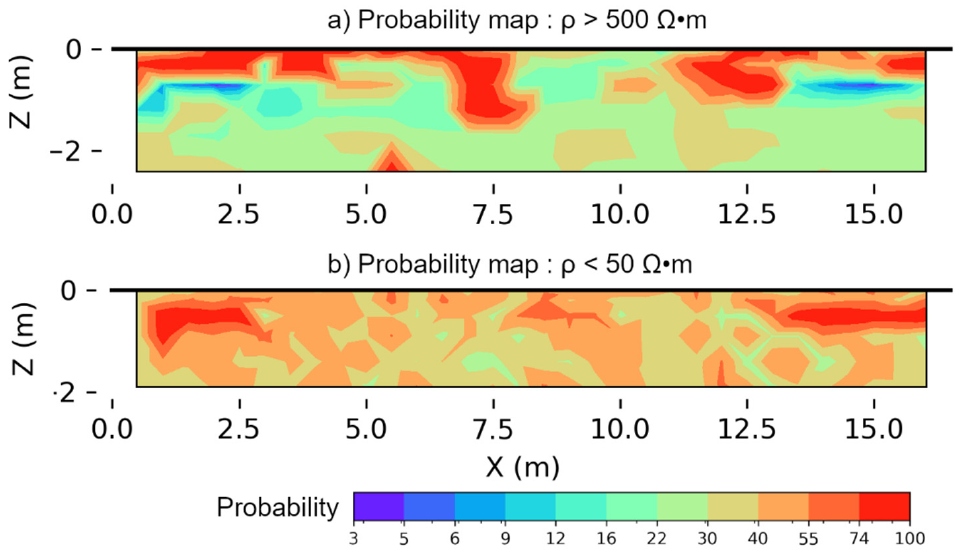
Figure 7. Resistivity model in probabilistic view deduced from the uncertainty analysis of the rebuilt equivalent models: ( a ) ρ > 500 Ω∙ m; ( b ) ρ < 50 Ω∙ m.